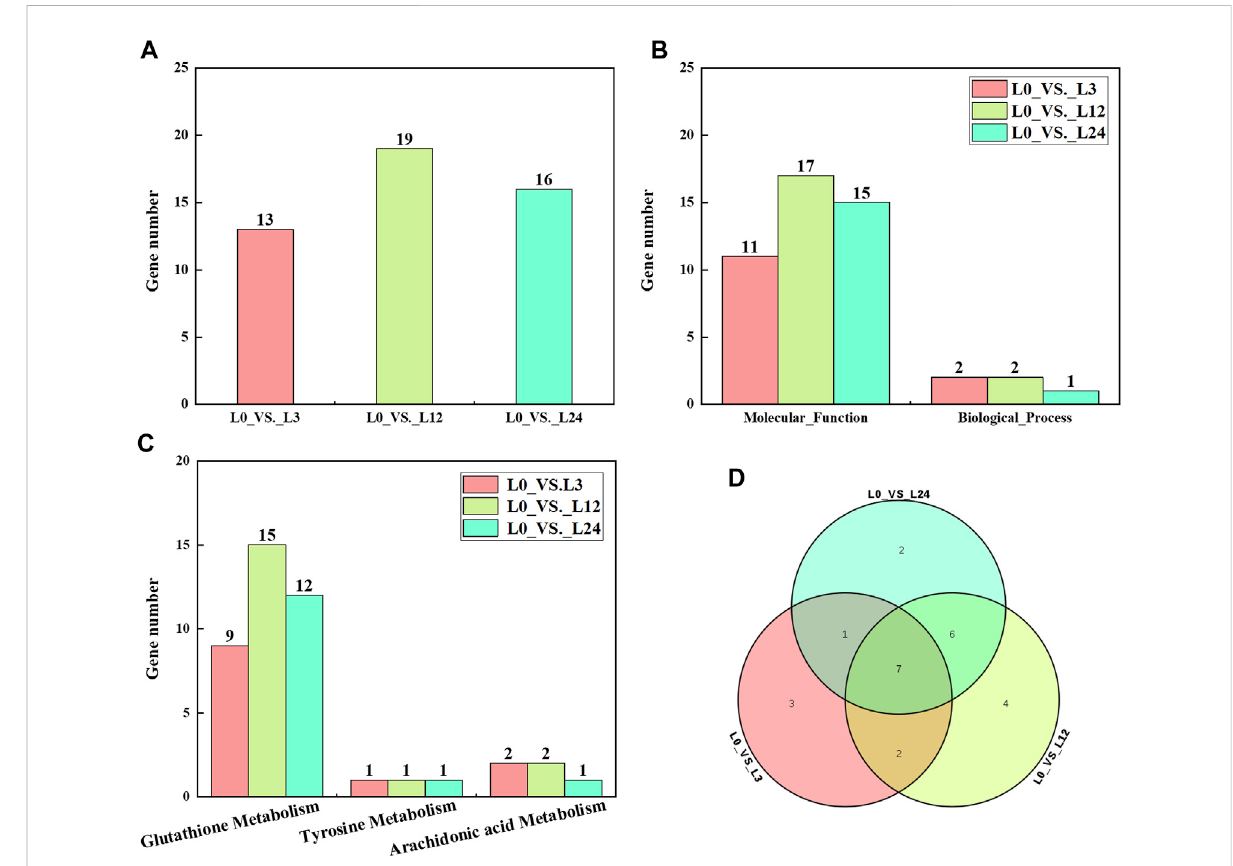
FIGURE 5 Analysis of differentially expressed CsGSTs. (A) The number of differentially expressed CsGSTs of different groups under cold stress. (B) The number of differentially expressed CsGSTs in GO annotation. (C) The number of differentially expressed CsGSTs in KEGG pathway enrichment analysis. (D) Venn diagram showing the number of common and unique differentially expressed CsGSTs among the different